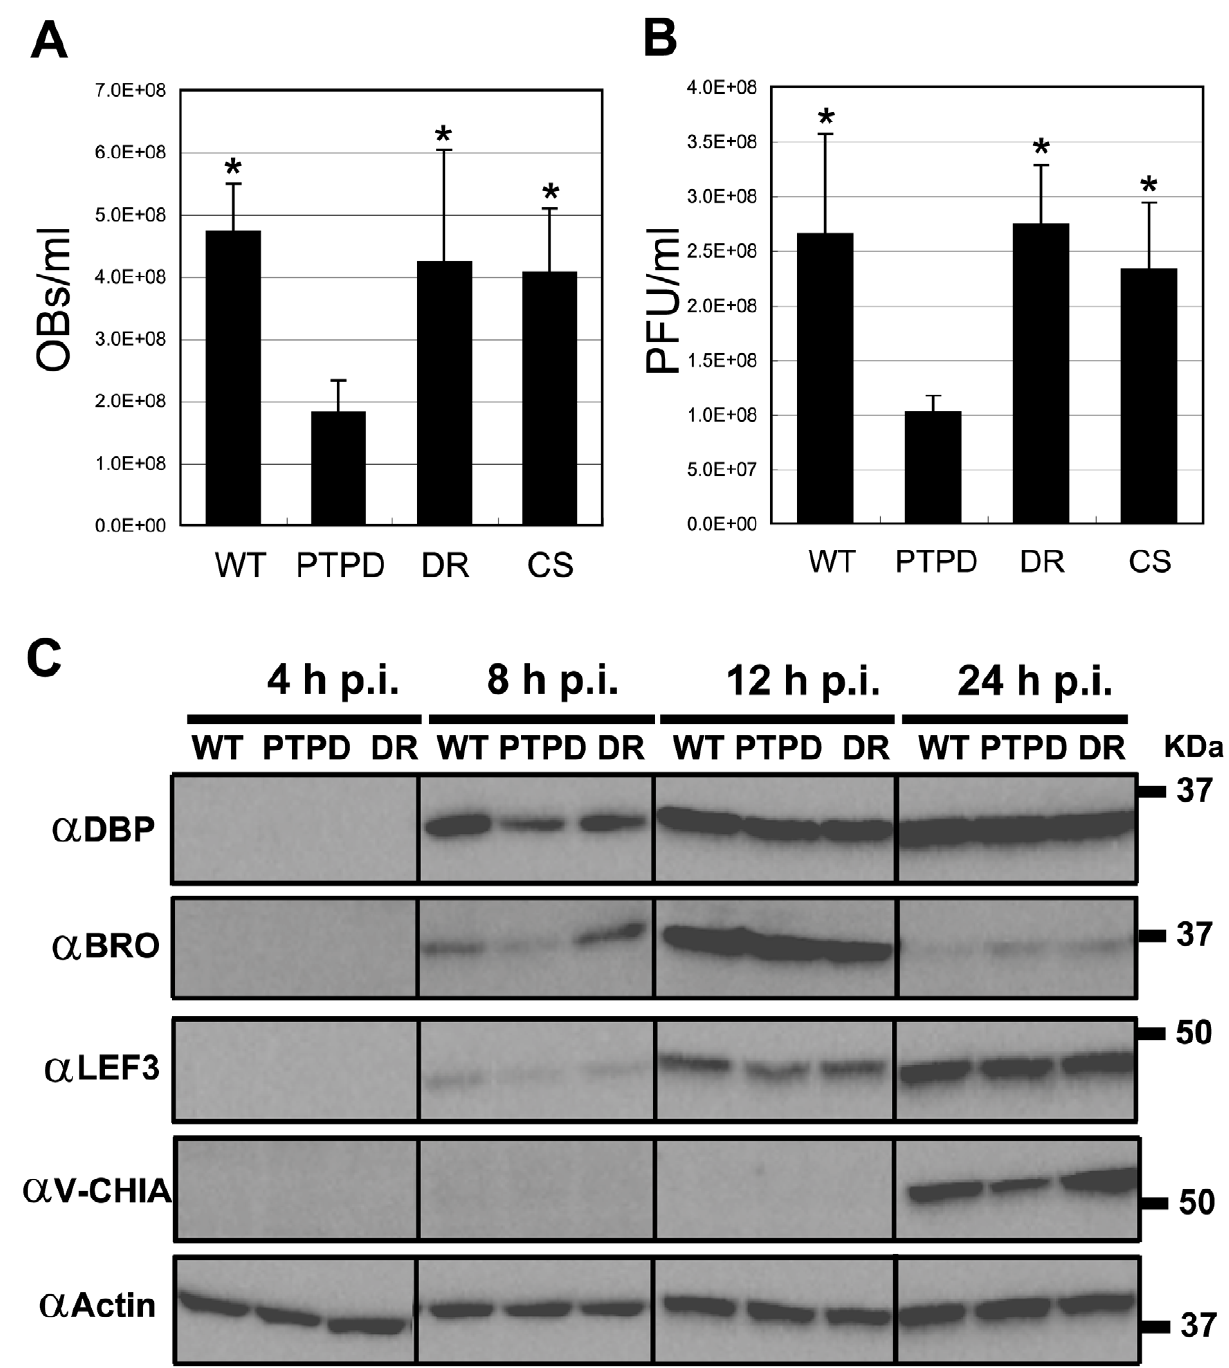
Figure 4. BmPTPD produces fewer progeny in 5 th instar B.mori and shows a delay in late gene expression in BmN cells. Production of OBs (A) and BVs (B) in the hemolymph of larvae infected with BmNPV, BmPTPD, BmPTPDR or BmPTP-C119S at 4 d p.i. Data shown are means 6 standard deviation (SD) (N=4). * p , 0.05, one-way ANOVA with Tukey’s post test in comparison to BmPTPD. (C) Western blot analysis of the expression of viral gene products in BmN cells infected with BmNPV, BmPTPD or BmPTPDR. The proteins were separated by SDS-PAGE, transferred to a nitrocellulose membrane, and immunoblotted with antibodies that recognize BmNPV early-expressed (DBP, BRO, and LEF3) or late-expressed (V- CHIA) proteins or actin. Similar results were obtained in two independent experiments. Abbreviations: WT, BmNPV; PTPD, BmPTPD; DR, BmPTPDR; and CS, BmPTPD-C119S. doi:10.1371/journal.ppat.1002644.g004 studies of the locomotory patterns in the brain and subesophageal virus-induced ELA. Our current hypothesis suggests that the ganglion from baculovirus-infected larvae will allow us to baculovirus plays a direct role in the induction of ELA by infecting understand what occurs in the central nervous system during the brain. However, other more subtle factors such as baculovirus-